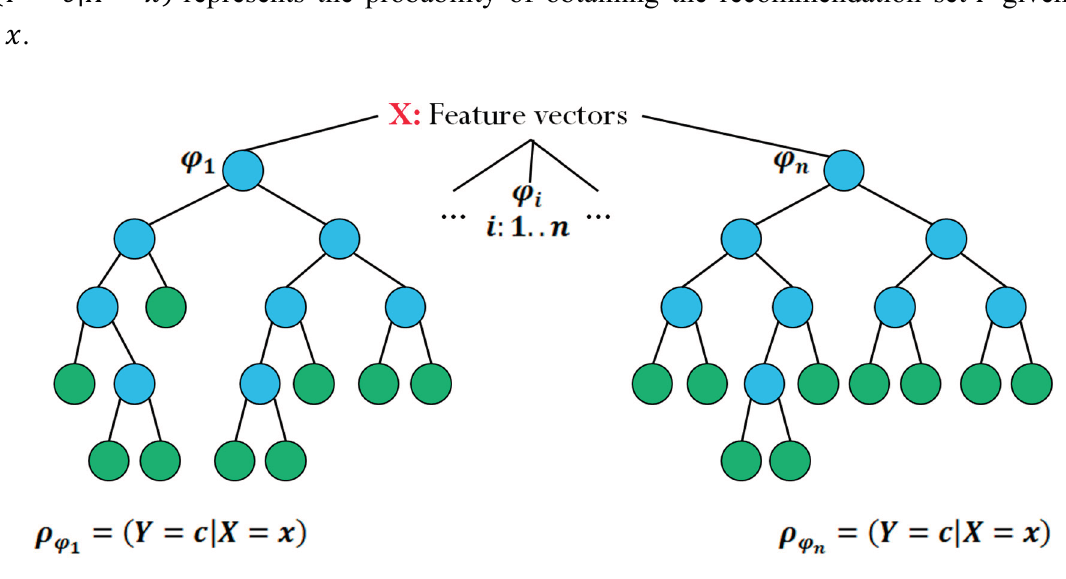
Figure 3. Example of randomized decision